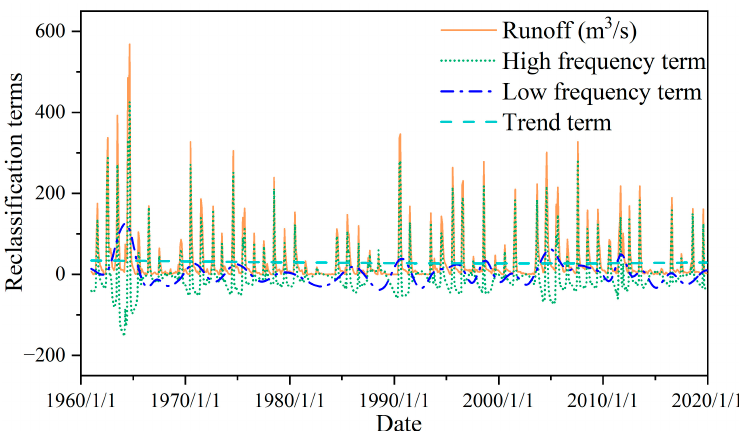
Figure 20. The reclassified IMF terms and original runoff data for Dawenkou station.